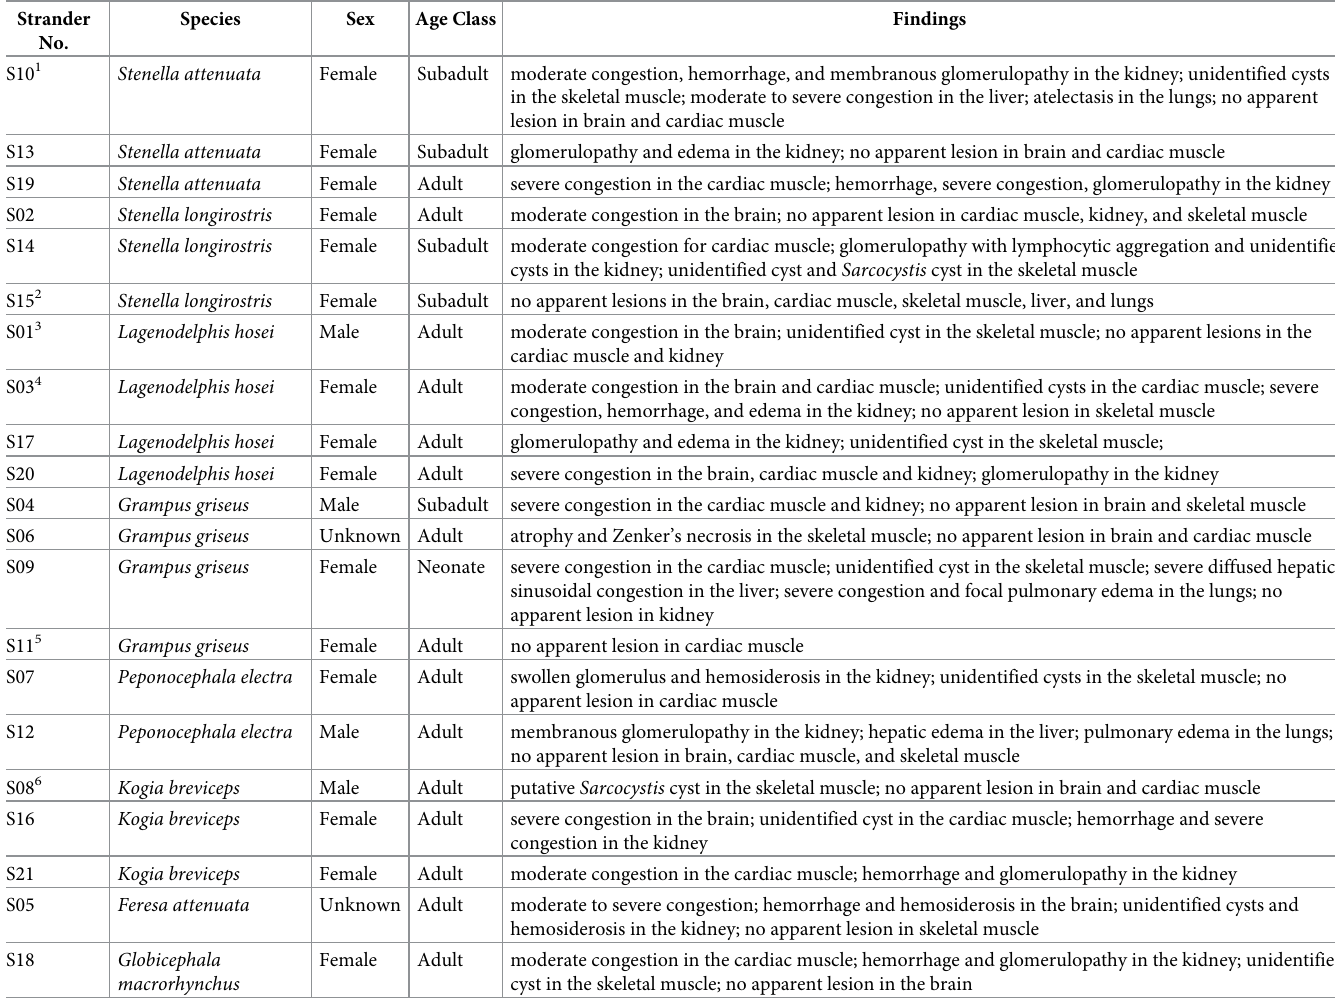
Table 3. Histopathological findings/remarks on cetaceans that stranded in the Philippines from February to April 2018. Strander